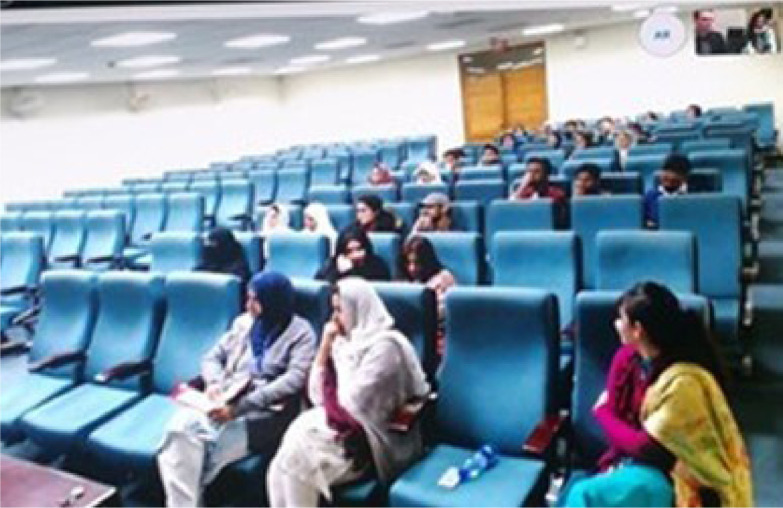
NUST University.